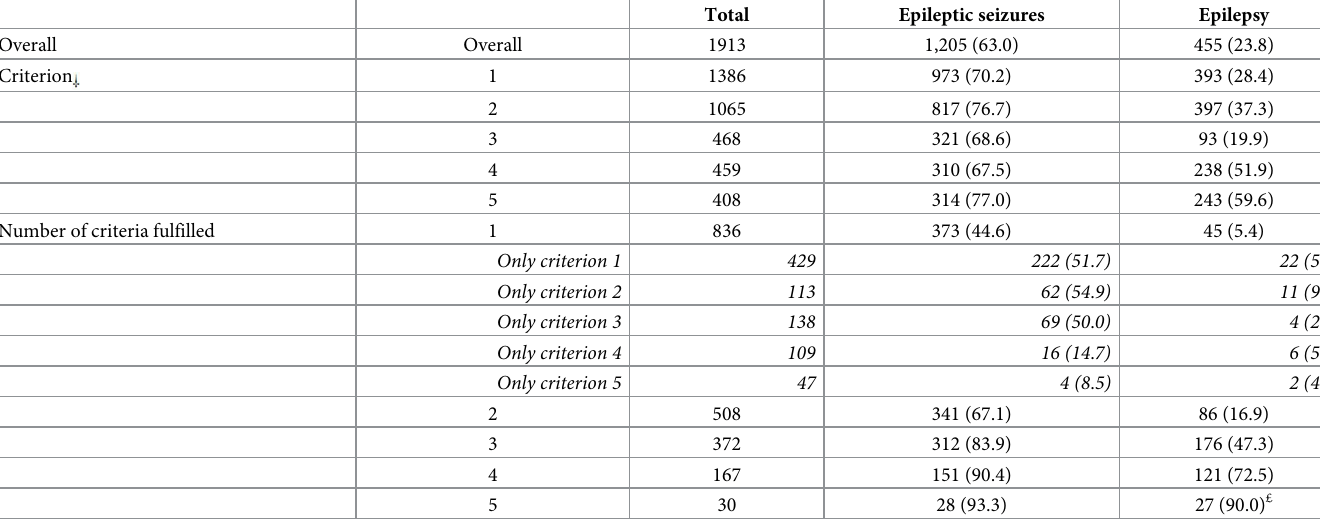
Table 3. Epileptic seizure screening criteria and confirmation of epileptic seizure/epilepsy cases in a rural population in Balaka district,